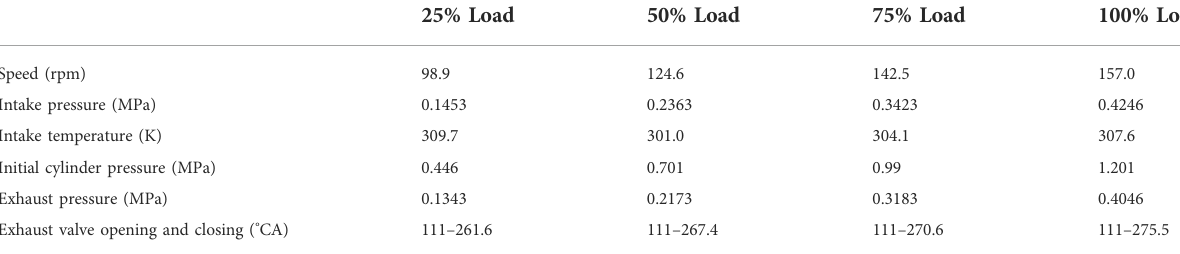
TABLE 5 Input parameter settings of the 6EX340EF engine under different